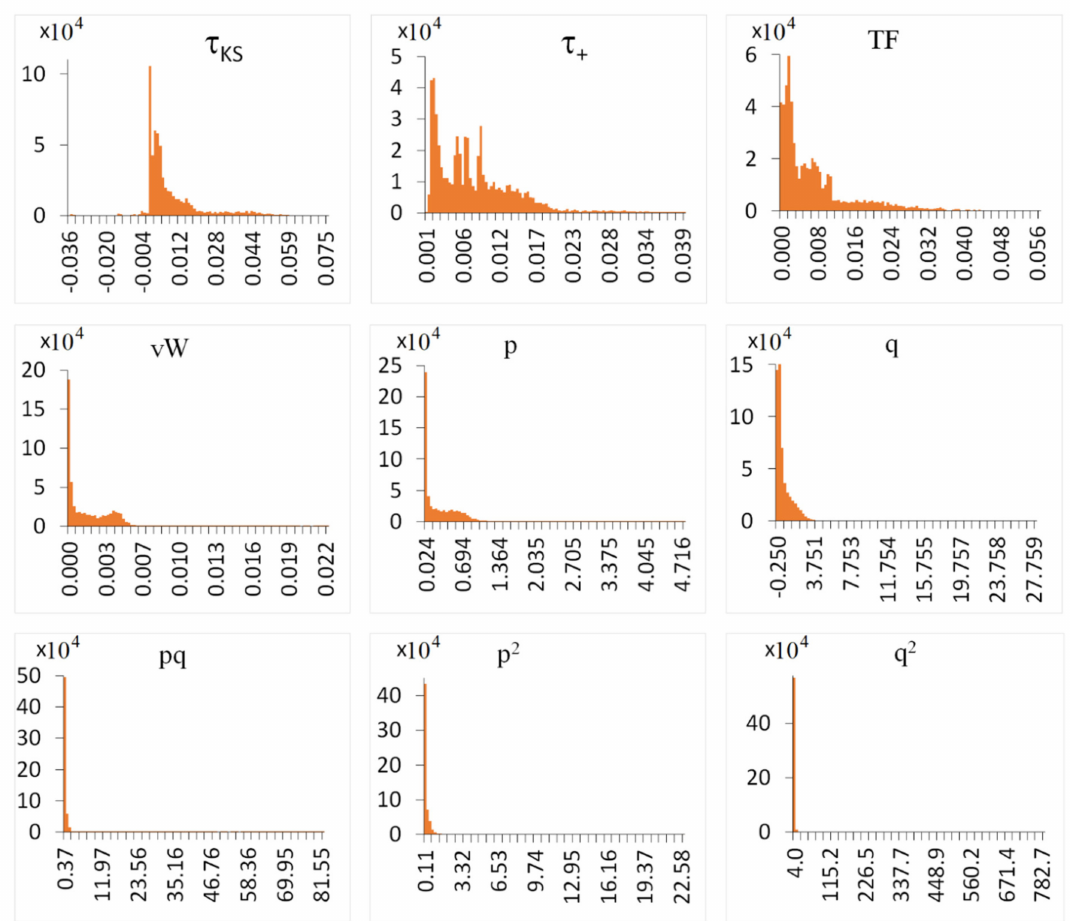
Figure 9. Distributions (histograms) of the kinetic energy densities and density dependent variables in a dataset combining data from Al, Mg, and Si at equilibrium geometry as well as under uniform compression and extension. Adapted with permission from [41]. Copyright 2020 American Institute of